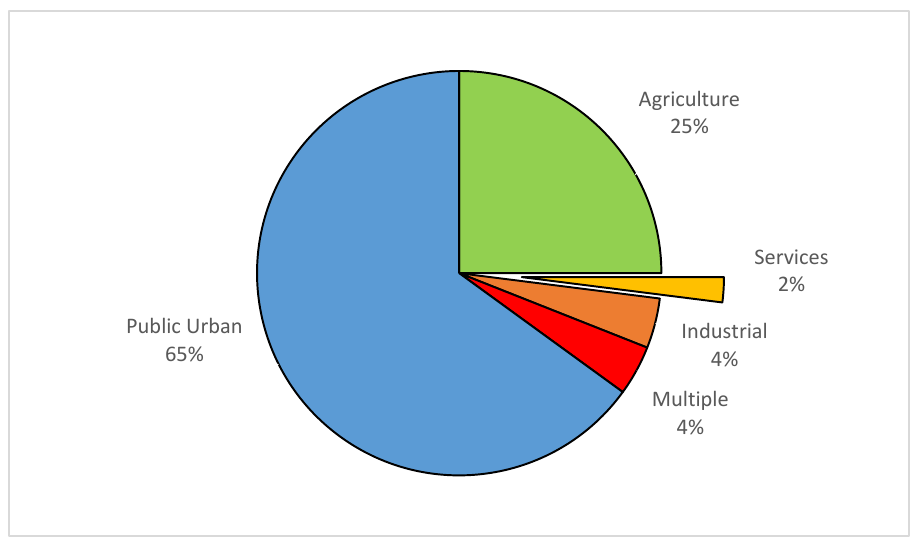
Figure 1. Groundwater use in the Cuautla river basin. Source [73].